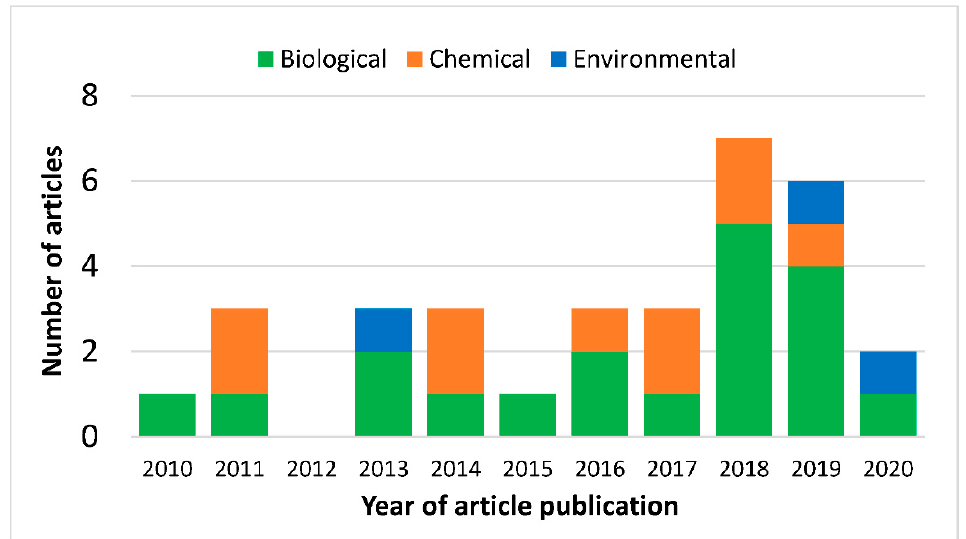
Figure 3. The yearly distribution of the number of selected published modelling articles with respect to the vector control types.